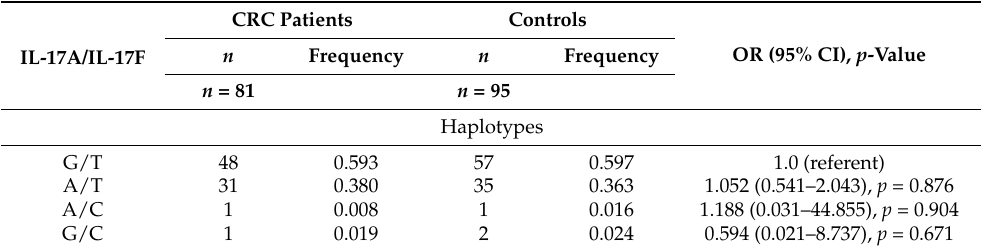
Table 7. IL17A and IL17F haplotype distribution among CRC patients and controls.